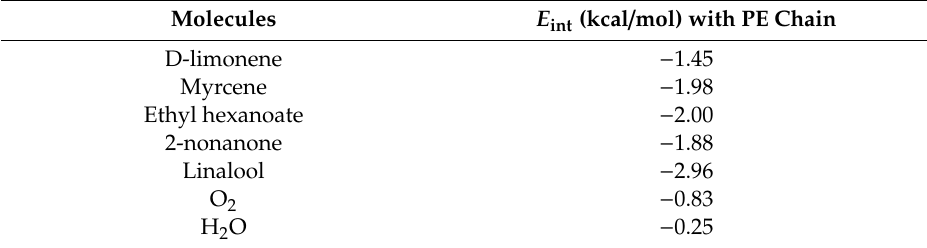
Table 2. Interaction energies between flavor, H 2 O, O 2 molecules, and PE chain. Molecules E int (kcal / mol) with PE